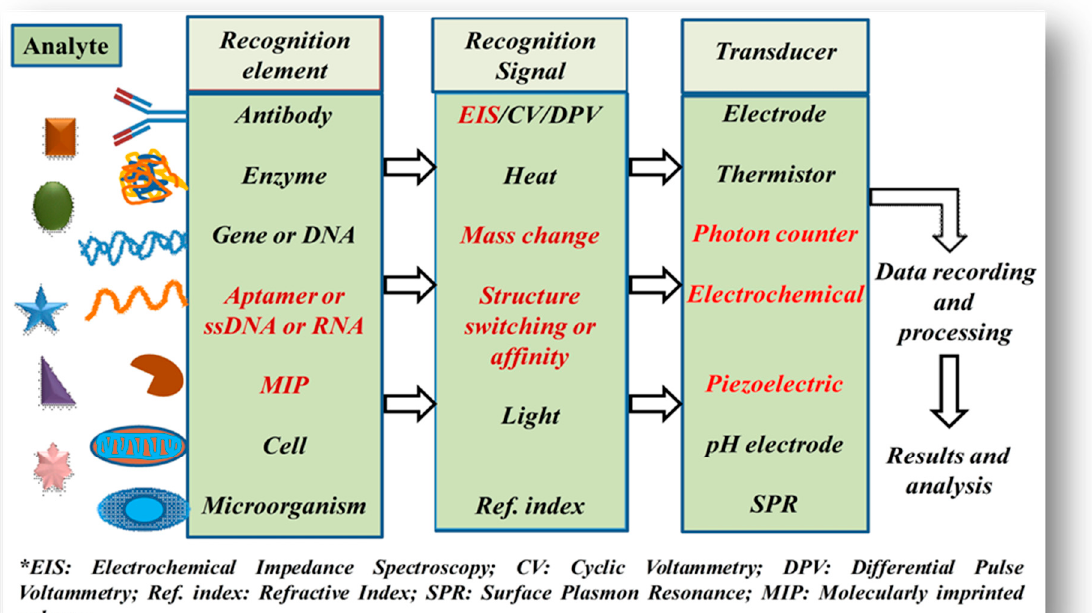
Figure 1. Schematic representation of biosensor components (illustrated from Sharma et al. 2017; Ref [8]) .